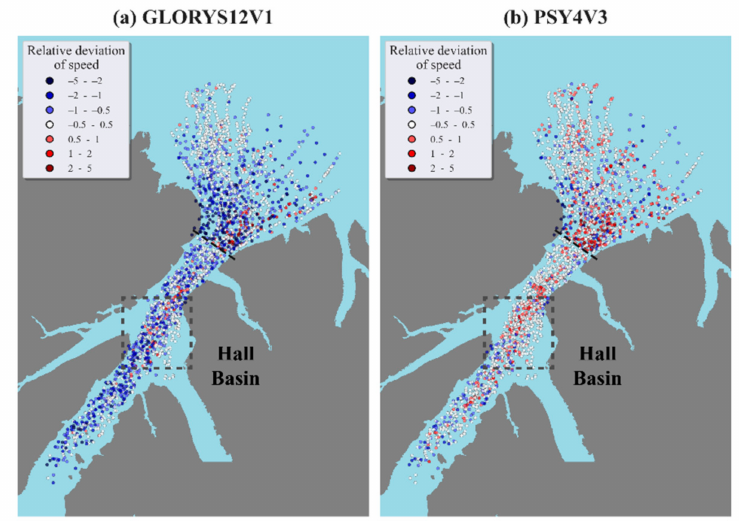
Figure 15. Spatial distribution of the relative deviation of ( a ) the GLORYS12V1 product and ( b ) the PSY4V3 product, compared with the Sentinel-1-estimated ice floe speed data inside and outside the Robeson Channel. The dots with different colors indicate the different deviation ranges. The black dotted line indicates the entrance from the Lincoln Sea to the Robeson Channel, which separates the two sub-regions. The dotted box indicates Hall